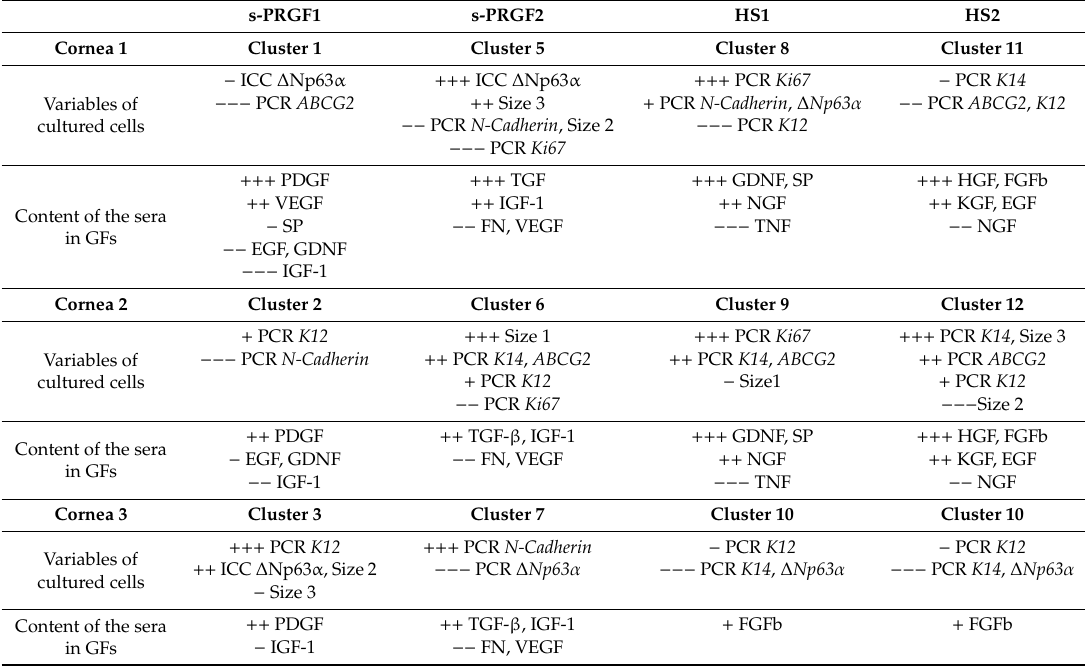
Table 4. Characteristics of each cluster of the hierarchical 12-cluster analysis. For each cluster, variables of cultured cells (expression of several proteins (ICC) or mRNA (PCR)), as well as the content of the human sera, in growth factors and signaling molecules are